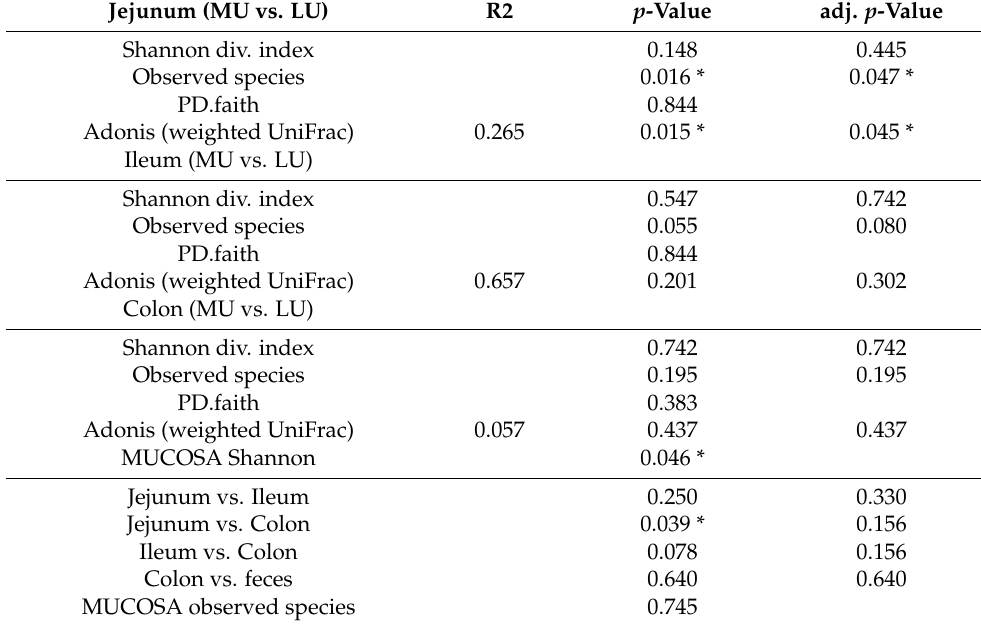
Adonis (weighted